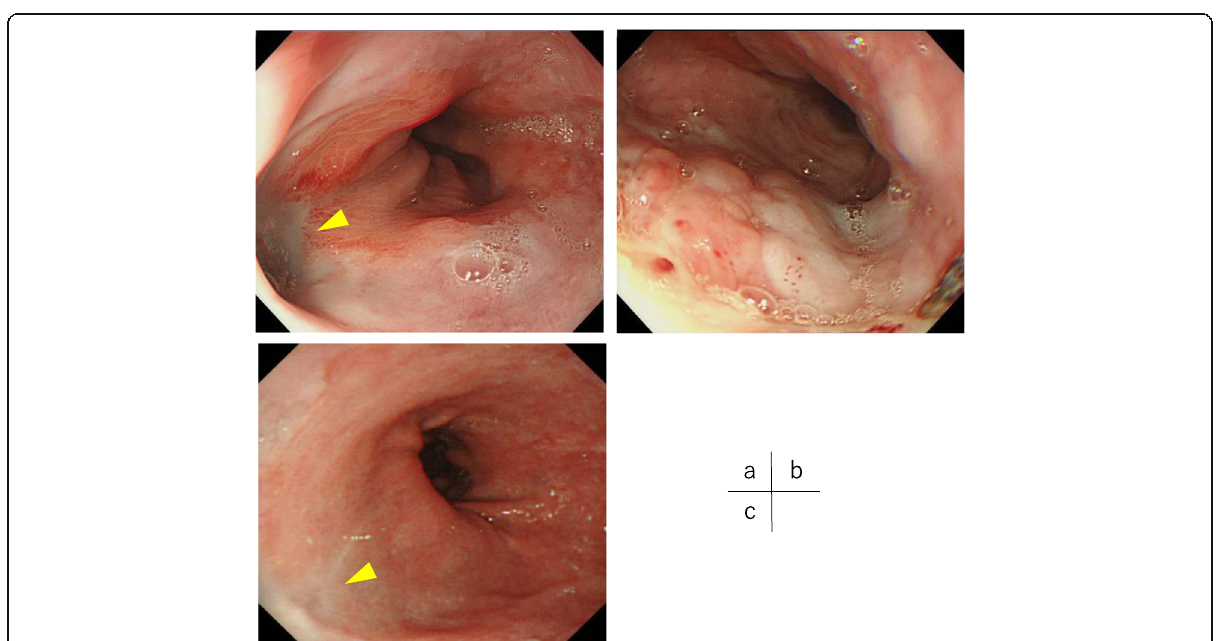
Fig. 3 Complete healing of the esophageal perforation. a Healing of the esophageal perforation on the 45th day (arrowhead). b There was granulomatous tissue growth around the esophageal stent. c Complete healing of the esophageal perforation at 4 months